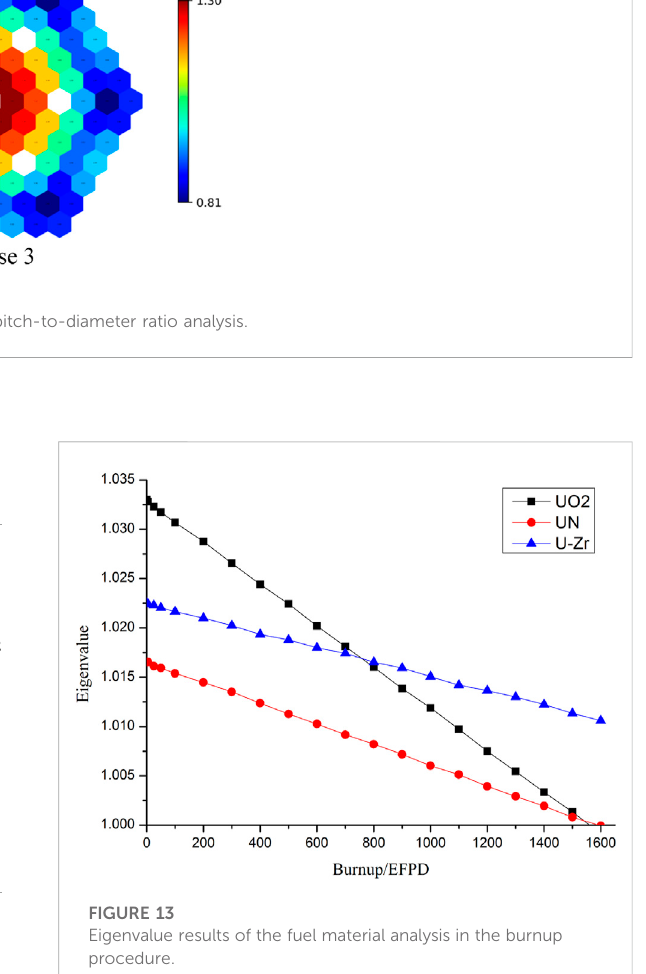
Figure 12. The radial assembly power peak factors were 1.32, 1.31, and 1.30 for the three cases, respectively, which also had unobvious differences.